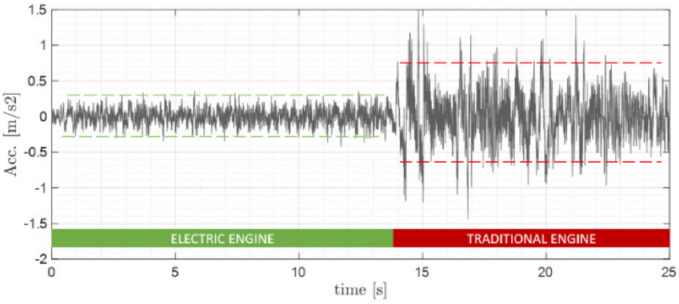
Figure 8. Comparison of the noise generated from two different